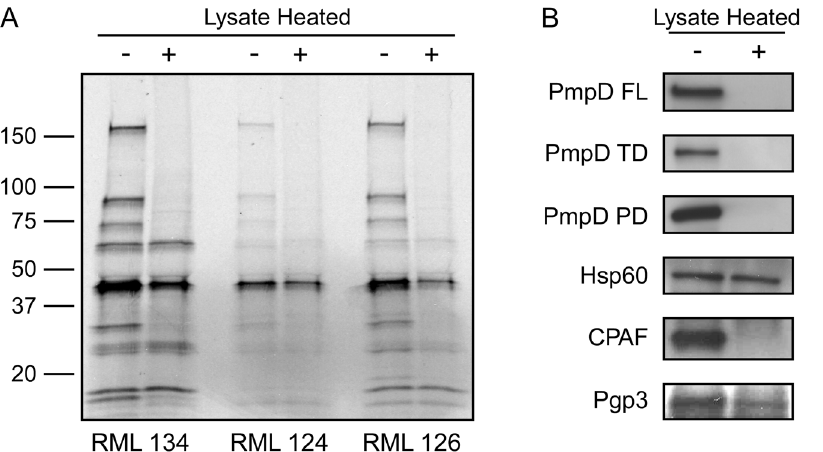
Figure 4. A majority of the antibodies generated against chlamydial specific and conserved antigens recognize conformational determinants. (A) RIP was performed with sera from all three infected NHP obtained from a single time point 13 weeks after re-challenge using A2497 infected cell lysates that were treated at 70 u C for 30 min or kept at ambient temperature. Heat treatment of chlamydial antigens partially destroyed antibody recognition of MOMP in all three monkeys. Heating also destroyed or partially destroyed the antigenicity of the majority of the other IP antigens indicating that antibodies generated against the antigens in the context of primary and re-challenge infections were specific to conformational determinants. (B) IPs were performed on heated and unheated A2497 infected cell lysates using sera from monkey RML 134 and gels probed by Western blotting with chlamydial specific antibodies to identify heat sensitive and resistant conserved antigens. Heat treatment completely inhibited antibody reactivity against full length PmpD and its two proteolytically processed polypeptides and CPAF. Pgp3 and HSP60 antigenicity was partially affected or not affected by heating, respectively.